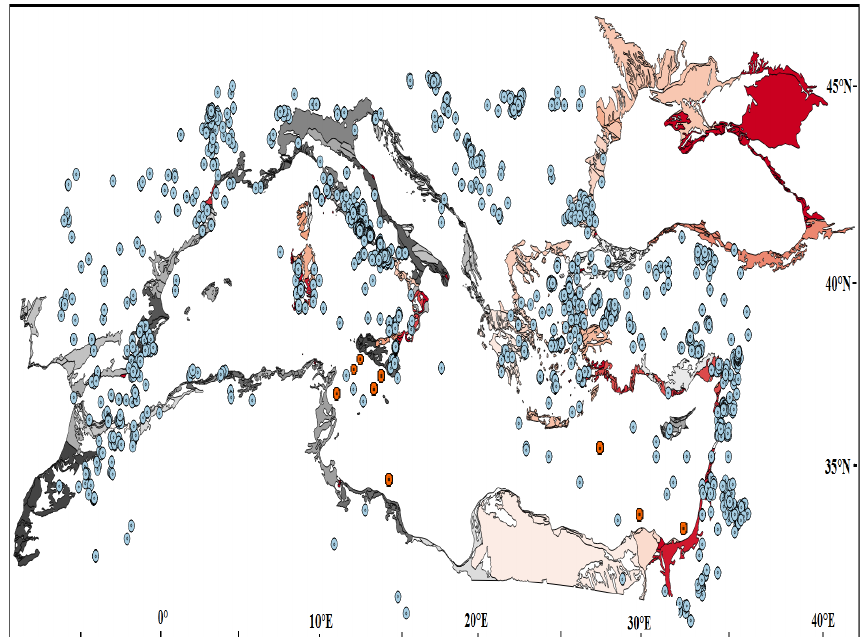
Figure 1. The filled contours indicate the geological province limit based on geological age (i.e. each colour represents an age) from a high- resolution digital geological map (http://www.geologie.ens.fr/spiplabocnrs/spip.php?rubrique67) while the circles filled in blue represent the location of the discrete data compiled from the EarthChem database (see Supplement 1), and in red the location of the stations correspond to the sediments analysed as part of the present